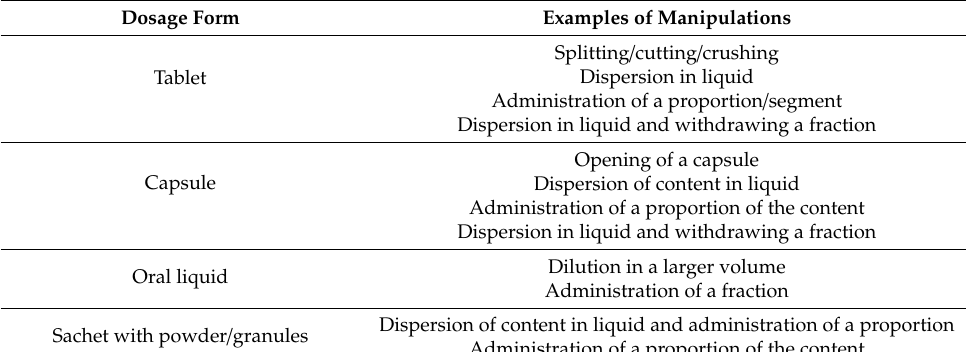
Table 1. Examples of the manipulation of di ff erent dosage forms (adapted from